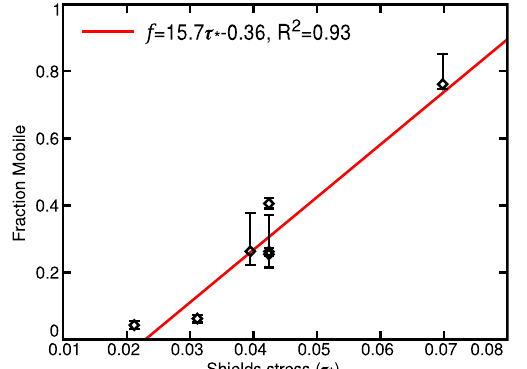
Figure 5. Fraction of mobile tracers ( f ) for single floods against peak Shields stress ( τ ∗ ). The red line represents the best fitting linear relationship, for which the intercept represents the critical Shields stress. See text for discussion of error bars.